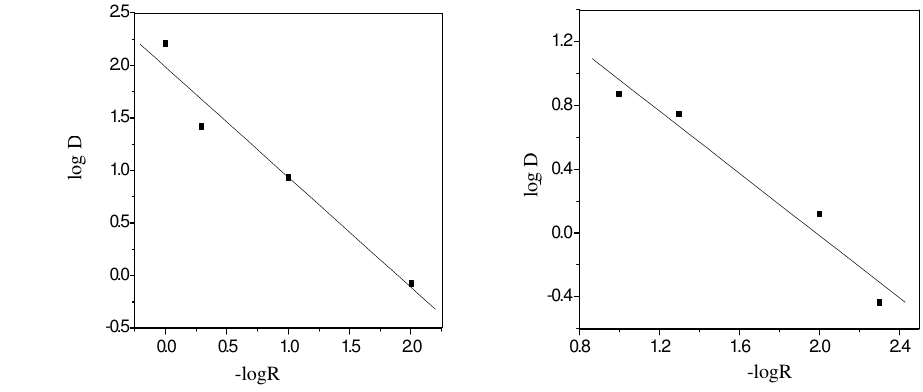
Figure 8. Plot of log D versus log [Phen - ] of bismuth(III) extraction from aqueous KI media at pH 1.2 onto the organic